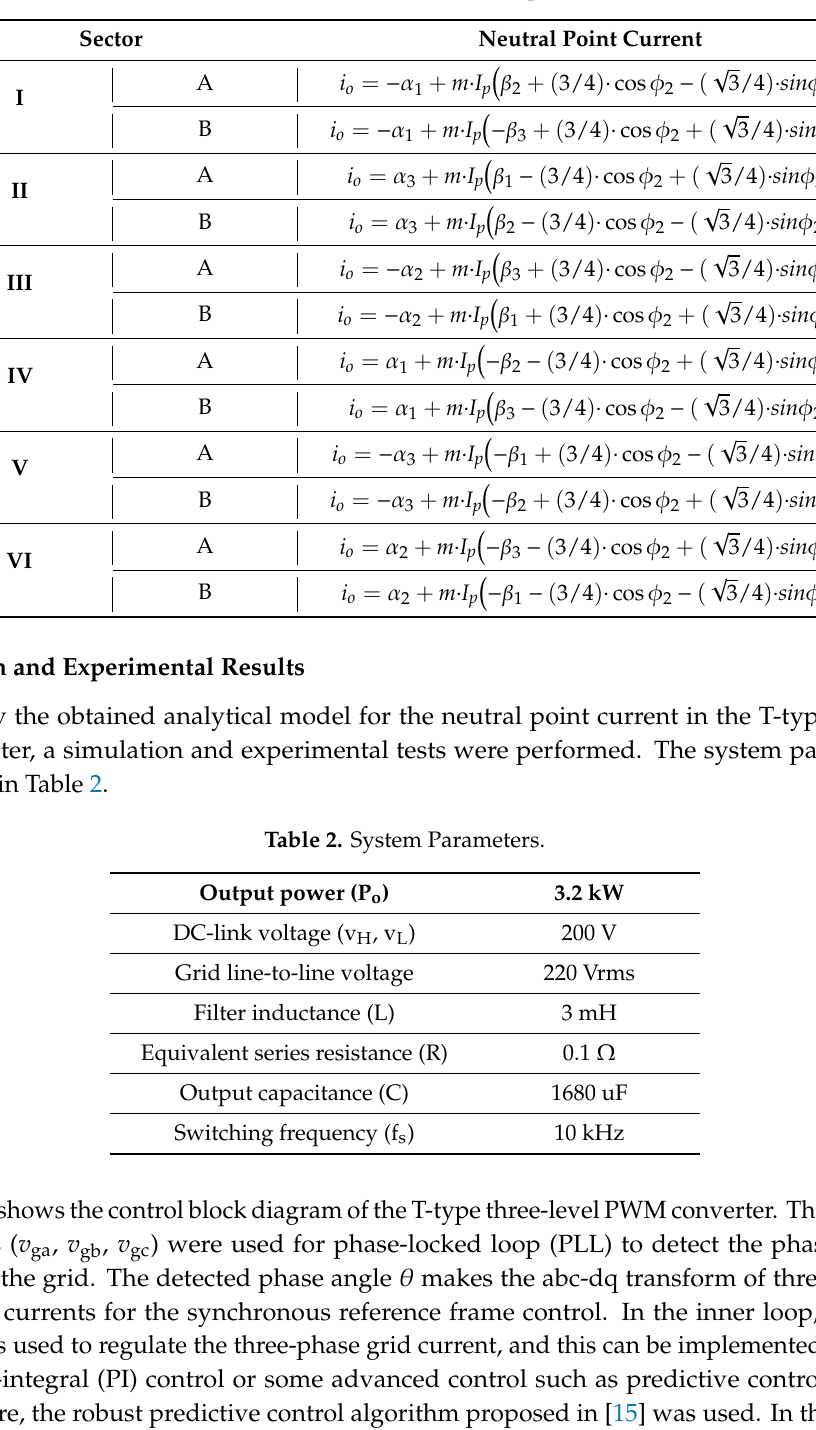
Table 1. Neutral Point Current Expression.